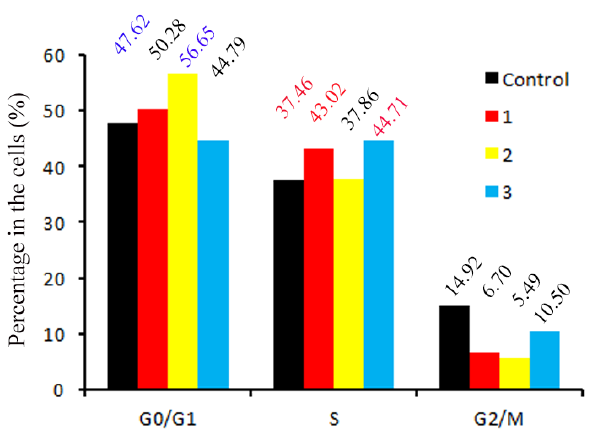
Figure 10. Cell cycle distribution of SGC-7901 cells after exposure to 1 (4.0 µM), 2 (15.0 µM), or 3 (15.0 µM) for 24 h.